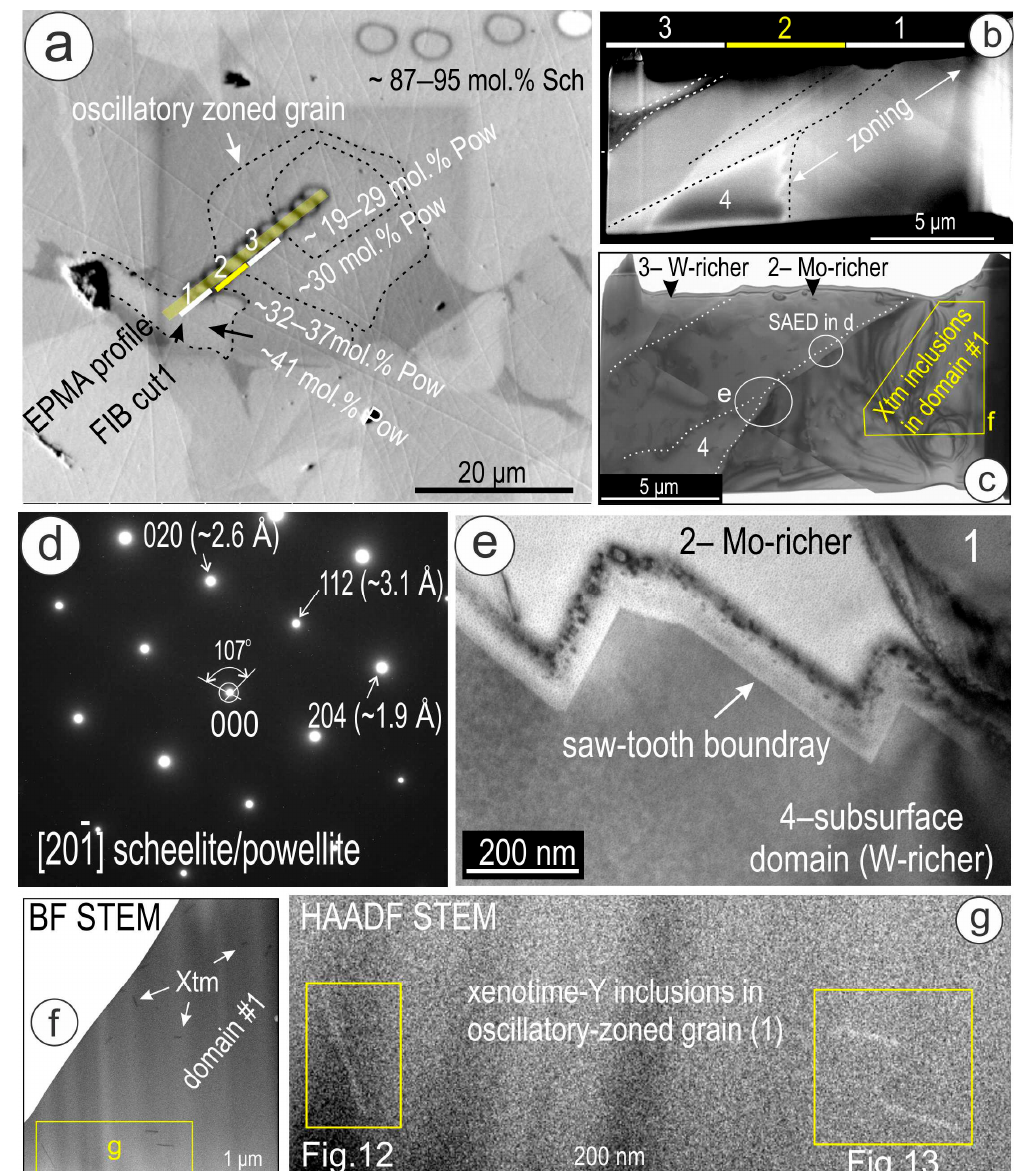
Figure 9. ( a – c ) Plan and depth views of the area sampled for the zoned grain of intermediate Sch-Pow composition. ( a ) BSE image showing the correspondence between EPMA spot analysis and the FIB cut across three distinct domains as marked. ( b , c ) Secondary electron (SE) and bright-field (BF) transmission electron microscopy (TEM) images showing the scanning TEM (S/TEM) foil. Note oscillatory zoning depicted on the SE image in ( b ) and also the presence of a fourth sub-surface domain. ( d ) Selected areas of electron diffraction (SAEDs) on [201(cid:3364)] scheelite/powellite showing no changes in orientation between different compositional domains [#1 and #2 as marked on ( c )]. ( e ) BF TEM image showing the boundary between different domains being affected by inclusions/pores and saw-tooth imbrication. ( f , g ) BF and high-angular annular dark field (HAADF) STEM images showing needle-like inclusions in the oscillatory zoned grain. Xtm—xenotime. The sample obtained from one of the slivers with the highest Mo-content shows continuation of oscillatory zoning at depth (Figure 10a–d). In this case, selected areas of electron diffraction (SAEDs) obtained from the sliver and the matrix are rotated to one another at ~80° about (01(cid:3364)1(cid:3364)) * on the